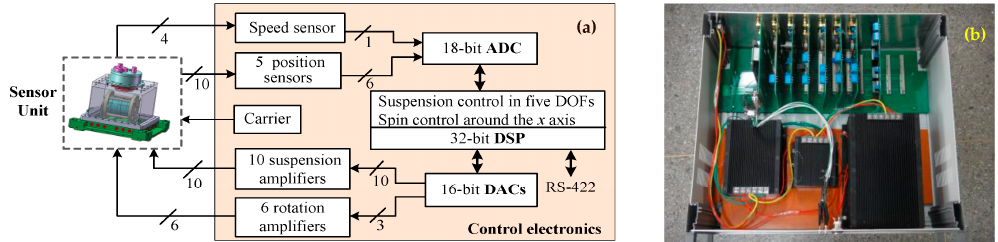
Figure 13. ( a ) Schematic of electrostatic suspension and rotation control electronics; ( b ) A photograph of the assembled control electronics unit.